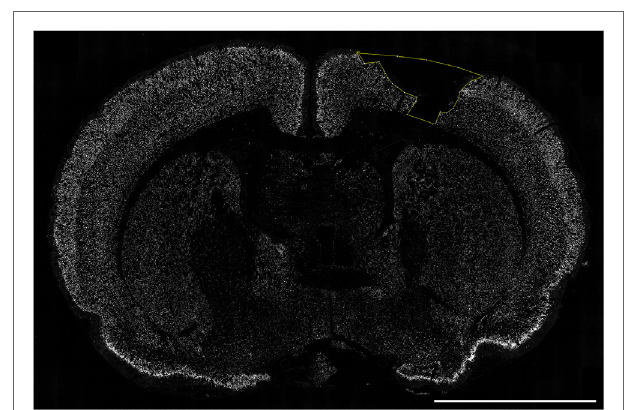
FigUre 4 | Quantification of cortical neuronal cell death . The section was labeled with NeuN (white) and the cortical lesion area (yellow) devoid of neurons was measured using the “Free hand” tool in ImageJ. Scale bar = 5